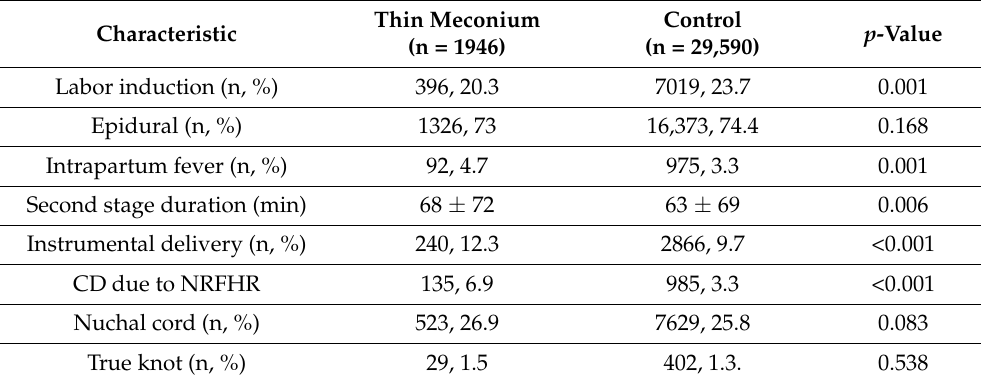
Table 2. Labor and delivery